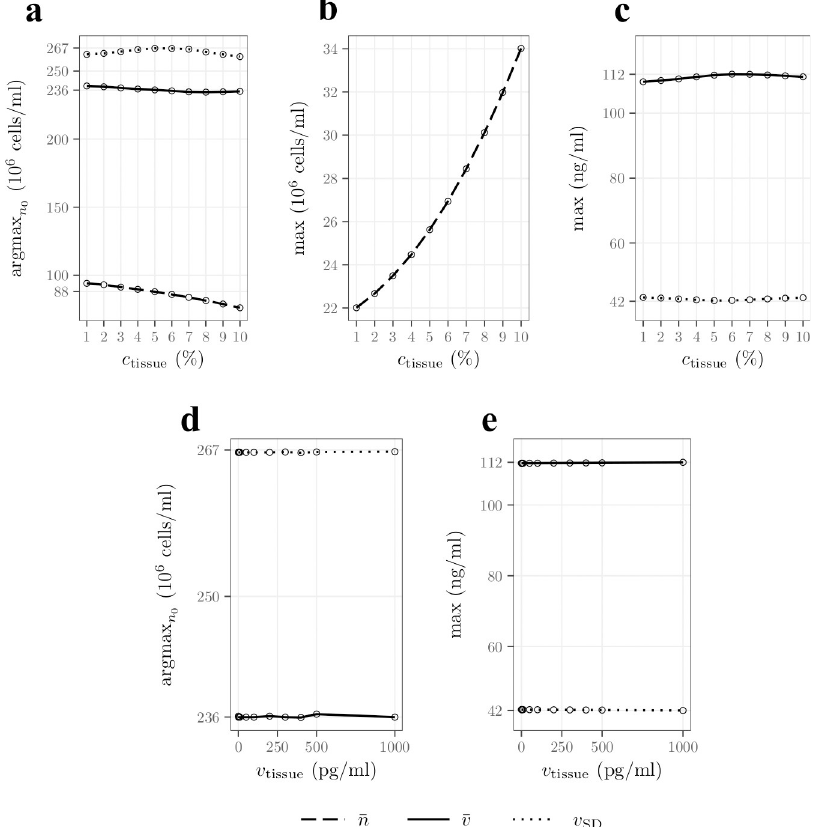
Fig 5. Increasing the surrounding oxygen tissue concentration supports fewer seeded cells and results in an increased cell density after 24h. A) initial cell density yielding the highest cell density ( argmax � v � , continuous line) and the largest VEGF concentration standard deviation highest VEGF concentration ( argmax n 0 ( argmax , dotted line) as functions of the concentration of oxygen in the surrounding tissue, i . e ., c tissue . B) max v n 0 SD � v � (continuous line) and max as a function of c tissue . C) max (dotted line) as functions of c tissue . D) argmax v n 0 n 0 SD (continuous line) and argmax (dotted line) as functions of the concentration of VEGF in the surrounding tissue i . v n 0 SD � v � (continuous line) and max (dotted line) as functions of v tissue on a e ., v tissue on a logscale. E) max v n 0 n 0 SD